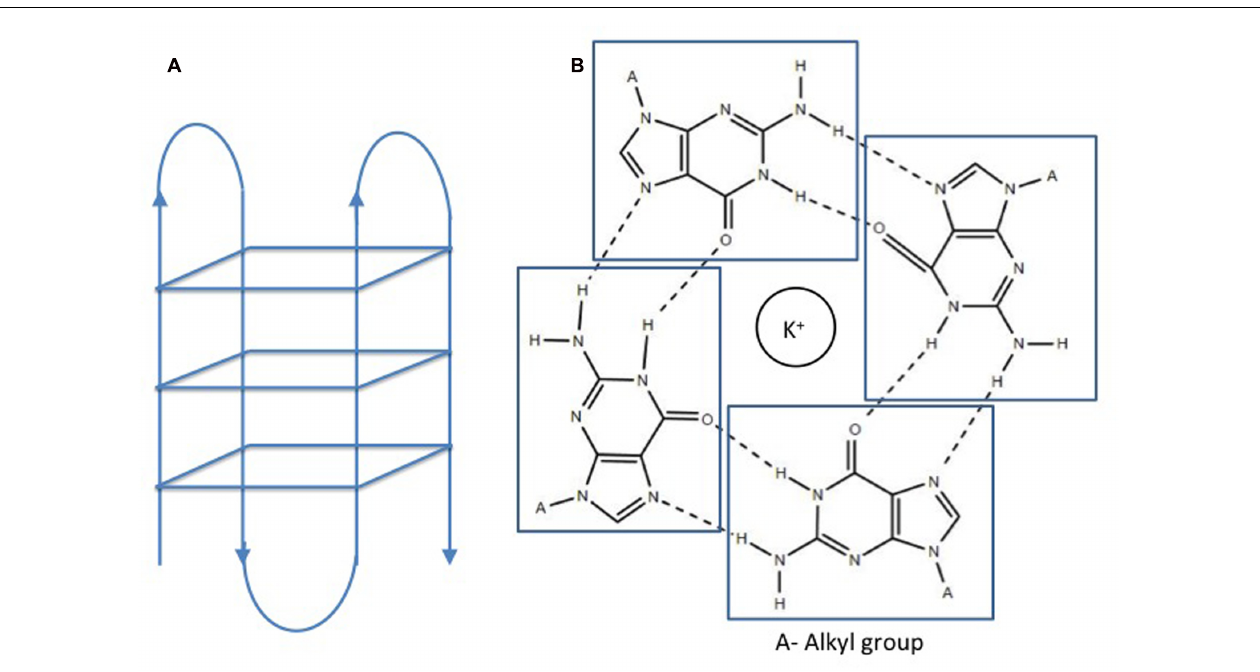
FIGURE 1 | Structure of a G quadruplex. (A) Intramolecular G quadruplex. (B) G quartet formation in presence of cations (Huppert and Balasubramanian, 2005). No permission is required for the modification and reproduction of this figure under the terms of the Creative Commons CC BY